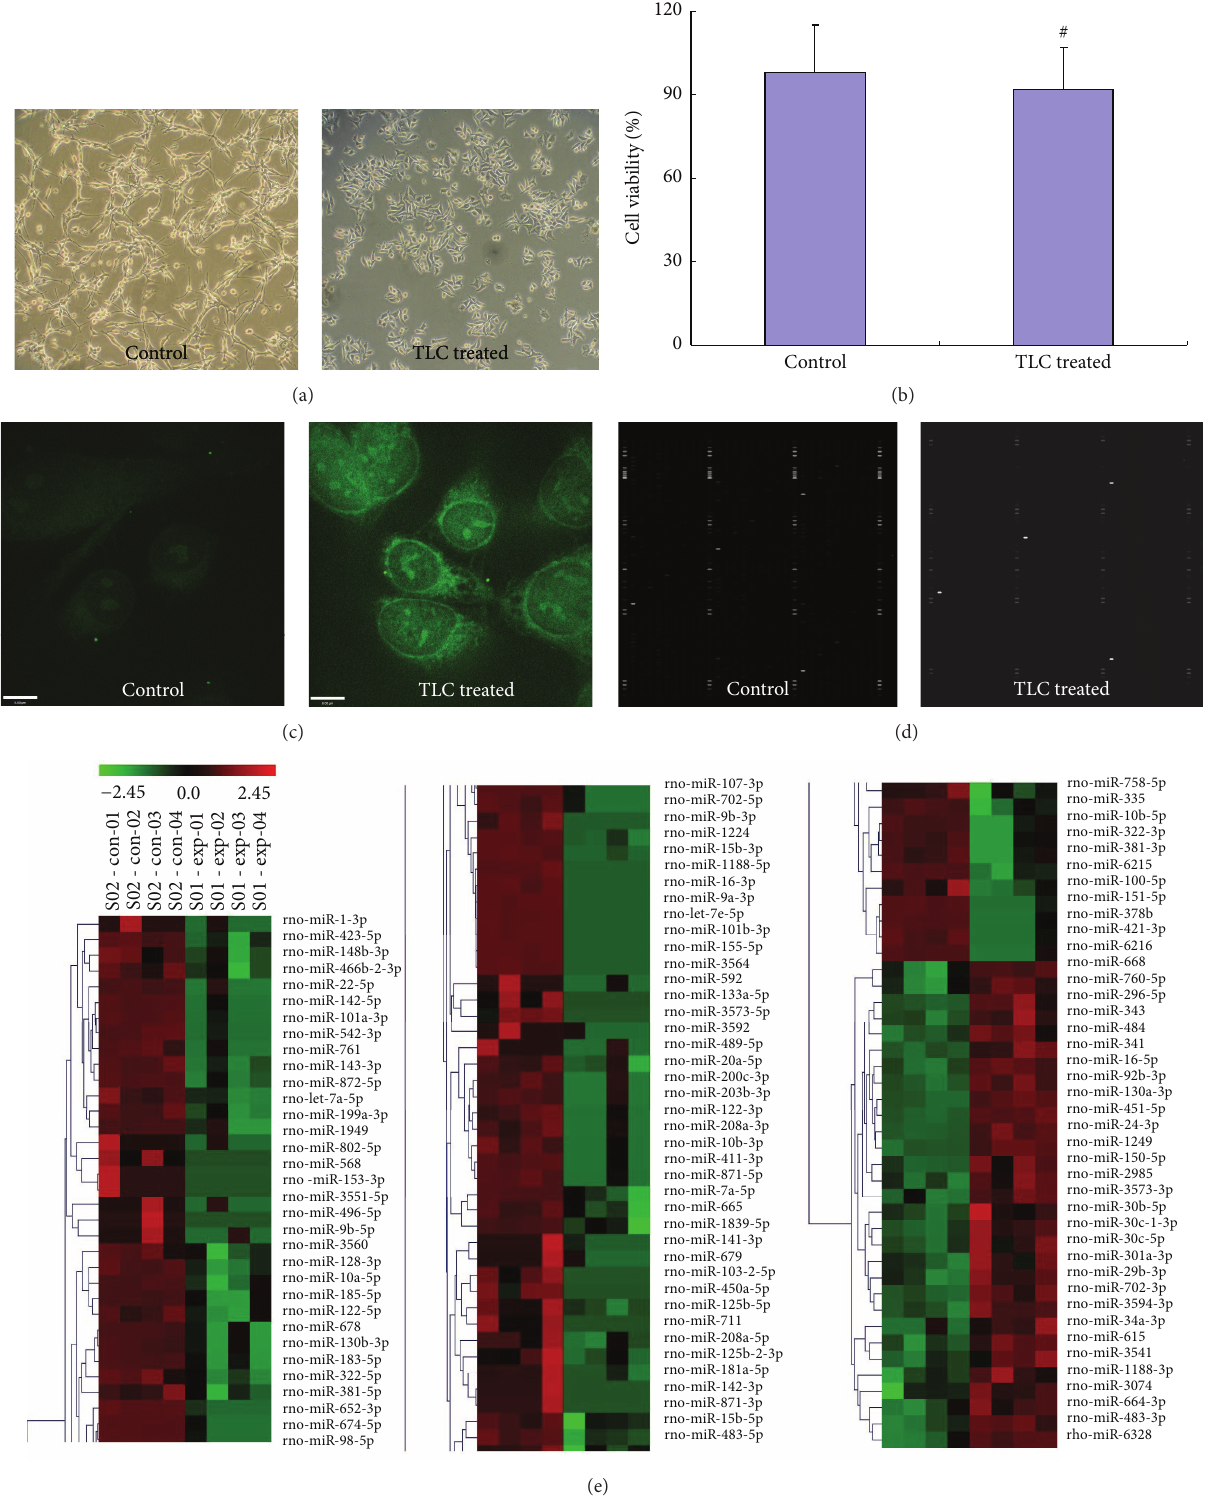
Figure 2: The microarray analysis of the exosomal miRNAs isolated from the culture medium of rat pancreatic acinar cells. (a) Microscopic images of cultured rat pancreatic acinar cells-AR42J cells. (b) MTT assay for detection of cell viability of AR42J cells; there is no significant difference between the two groups, # 𝑃 > 0.05 . (c) Laser confocal microscopic images of AR42J cells labelled by BZiPAR for assessing intracellular trypsinogen activation. (d) Microarray hybridization profiles of exosomal miRNAs isolated from the culture medium of AR42J cells. (e) Cluster analysis diagram. Green denotes miRNAs expressed at low levels in the corresponding samples, whereas red denotes the miRNAs expressed at high levels in the corresponding